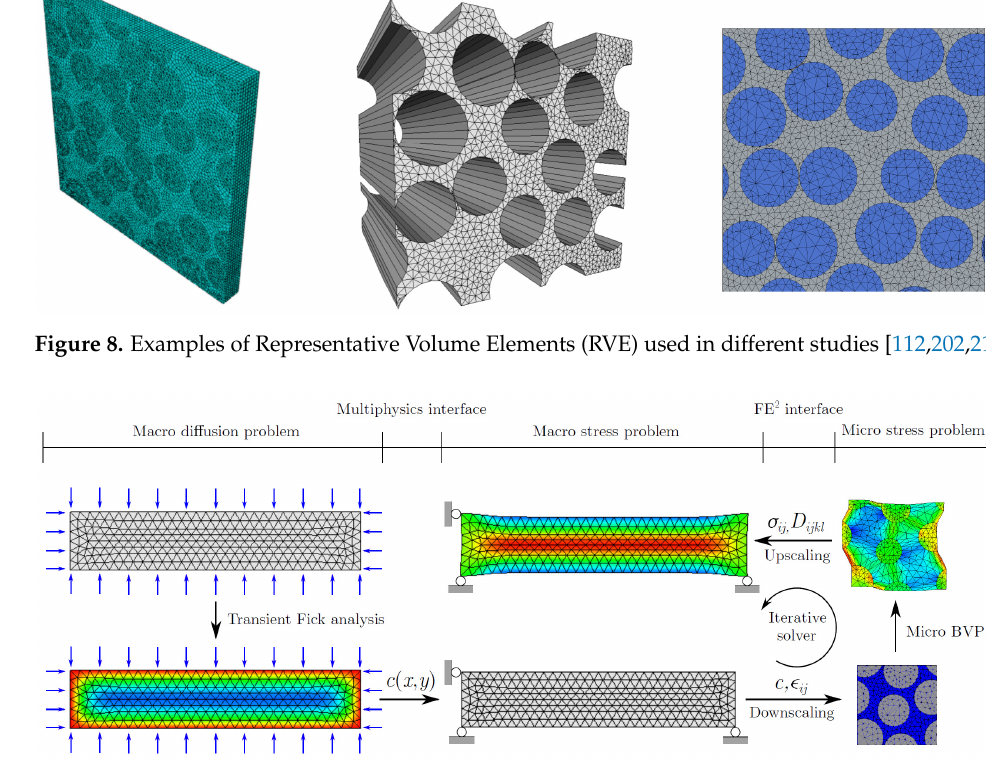
Figure 9. The FE2 framework for hygrothermal ageing was proposed by Rocha et al. [209].